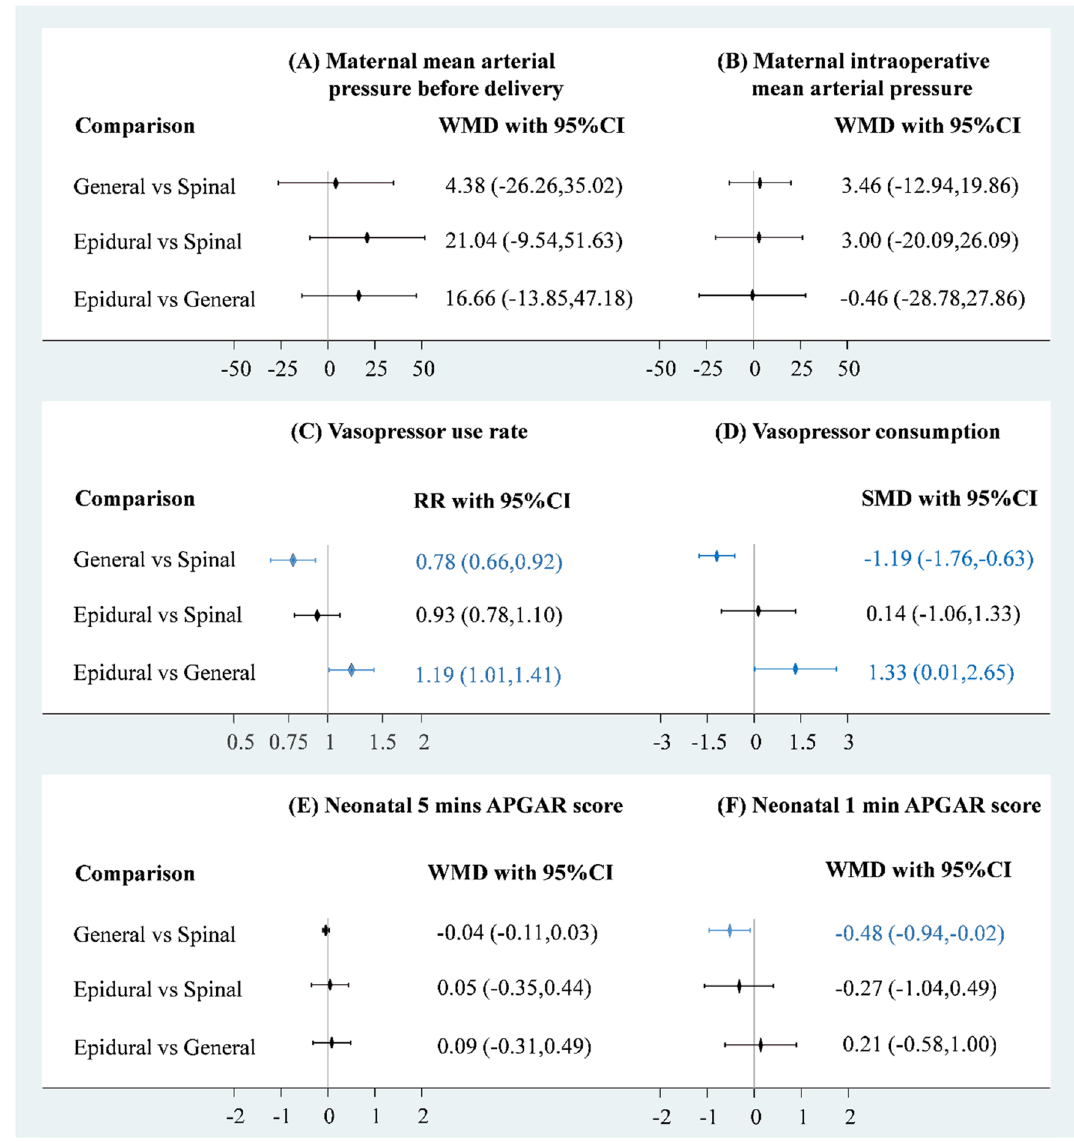
Figure 3. Forest plot of anaesthesia strategies for ( A ) maternal mean arterial pressure before delivery, ( B ) maternal intraoperative mean arterial pressure, ( C ) vasopressor consumption, ( D ) vasopressor use rate, ( E ) neonatal 5 min APGAR score, and ( F ) neonatal 1 min APGAR